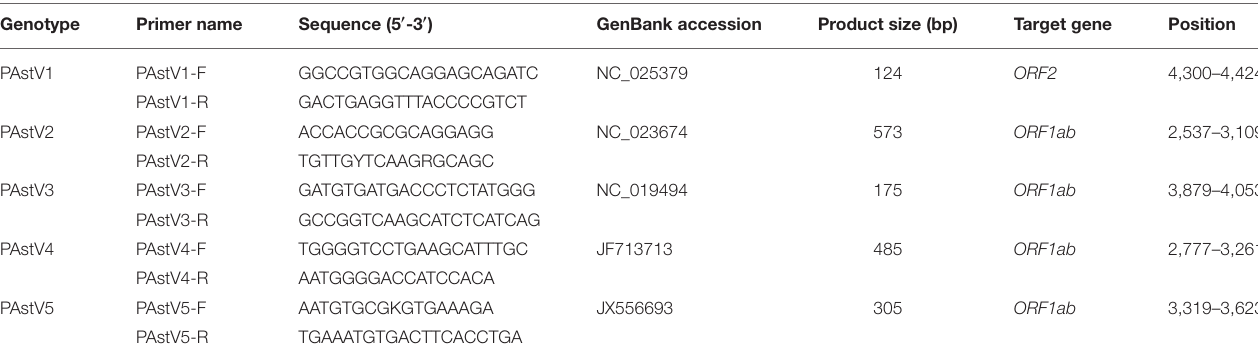
TABLE 1 | Multiplex primers used in this